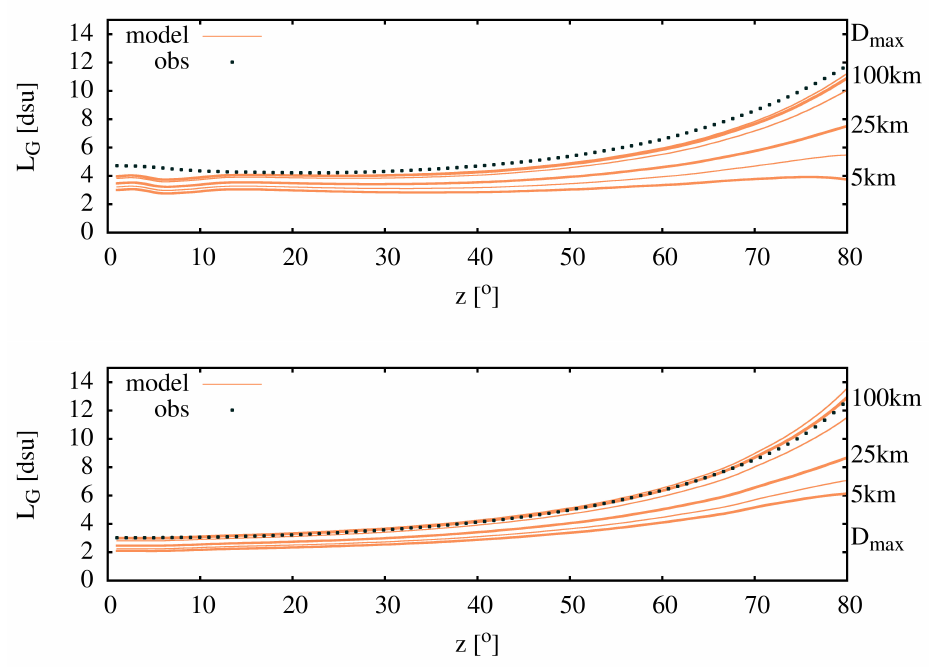
Figure 9. The mean radiance of the sky as the function of the zenit distance. Top: first observation with AOD = 0.02; Bottom: second observation with AOD = 0.05. The models are calculated for the sources within a given distance. The limit distances are 5, 12, 25, 50, 100 and 200km, from bottom to top. The limiting distance is indicated at the right side of the figure for the thick lines. The intermediate values for the thin lines are D max = 12km and